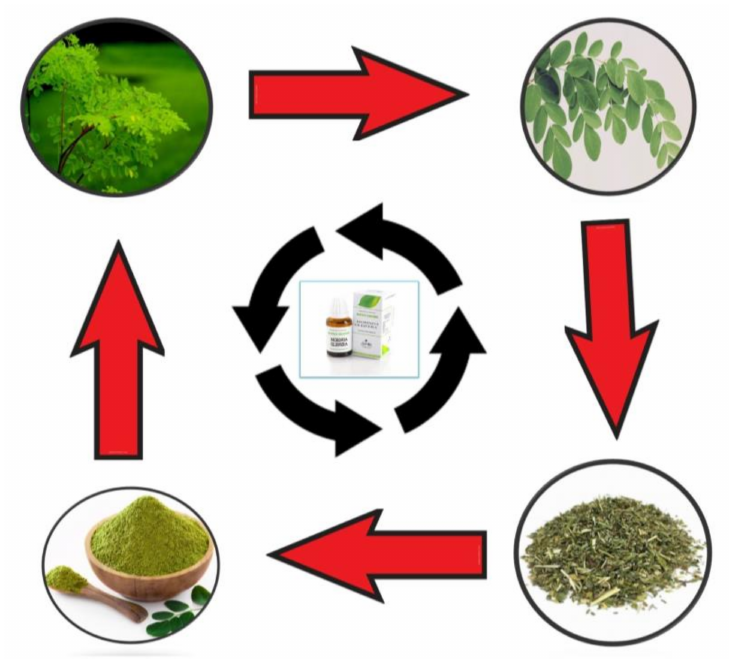
Figure 2. Main uses of Moringa : fresh, powder, as well as commercial preparations.